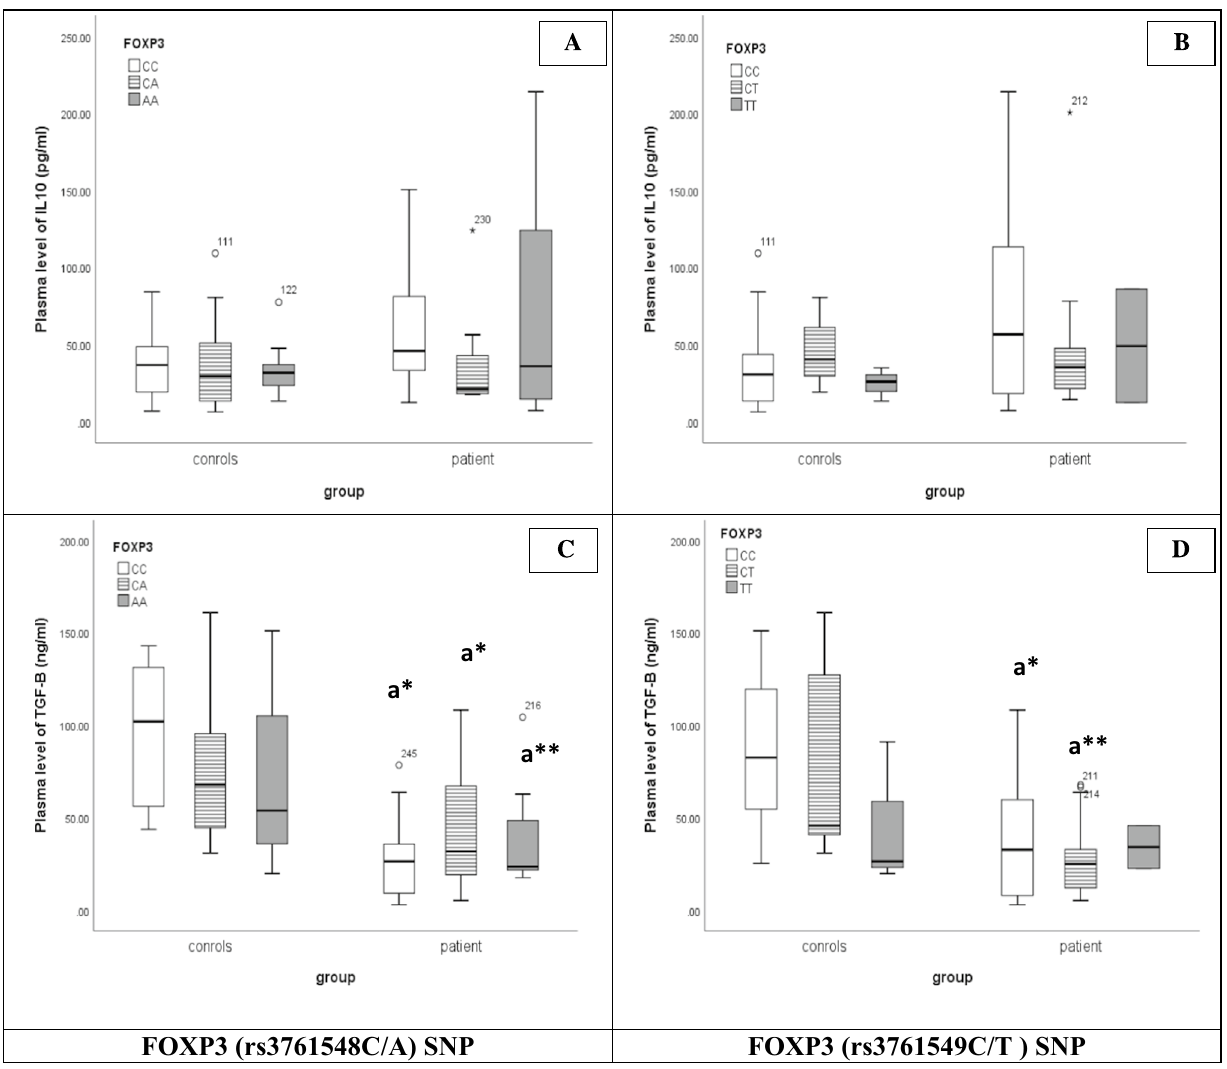
Fig. 3 Association between FOXP3 SNPs [rs3761548C/A ( A , C ) and rs3761549C/T ( B , D ) and Treg related cytokine (IL-10 & TGF-β; respec- tively) in controls and patients. Line inside the box representing Median, Boxes representing 25th and 75th percentiles and the lines outside the boxes indicating 10th and 90th percentile. a: relative to control; *:p < 0.05/NS, **: p < 0.01/p < 0.05